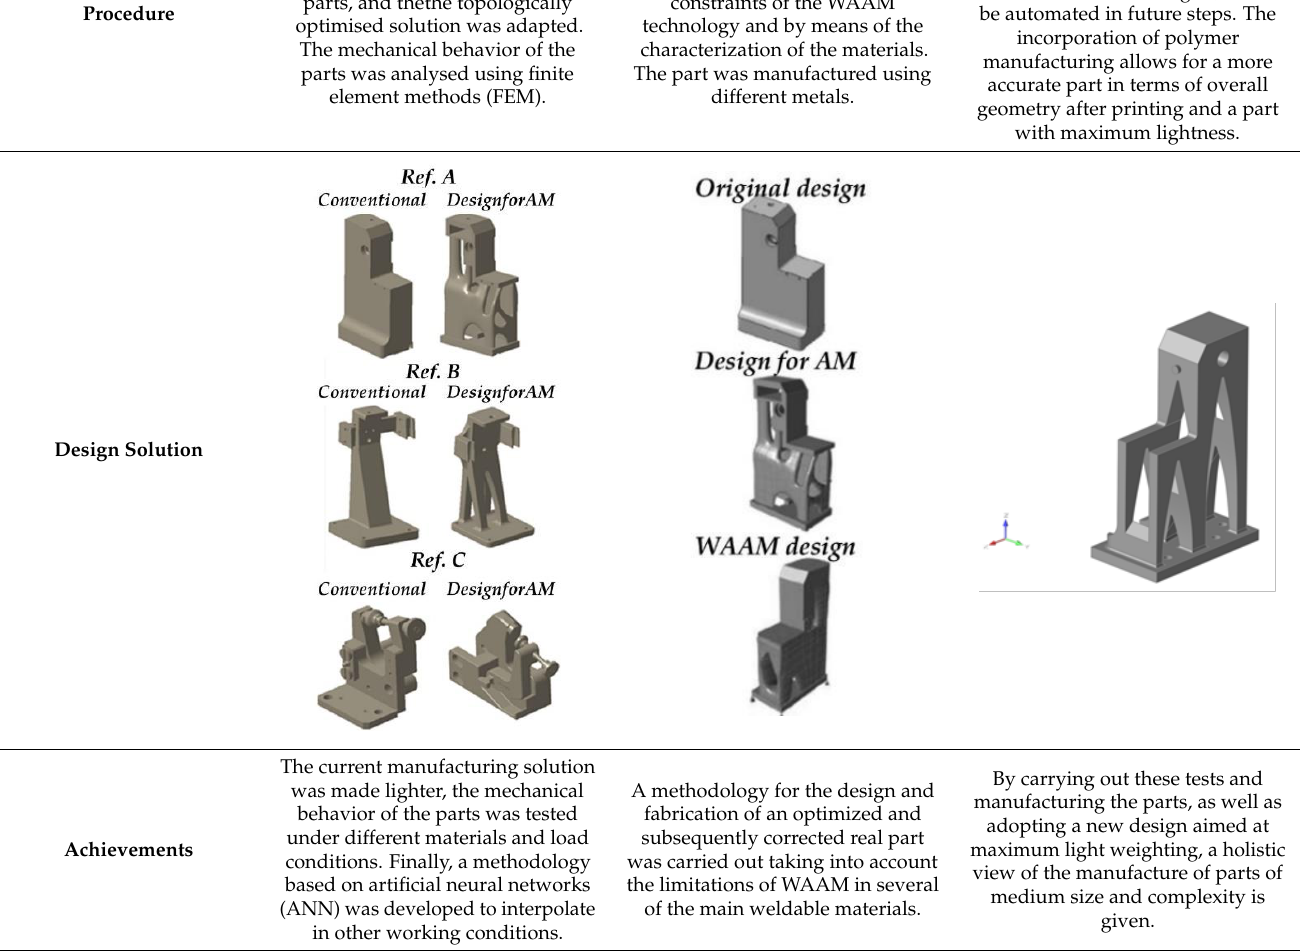
Table 1. Summary of the related work carried out by the research group.